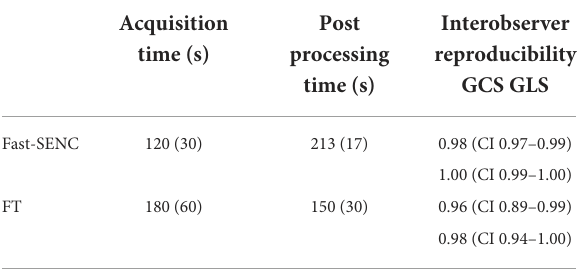
TABLE 6 Time spent in data collection and